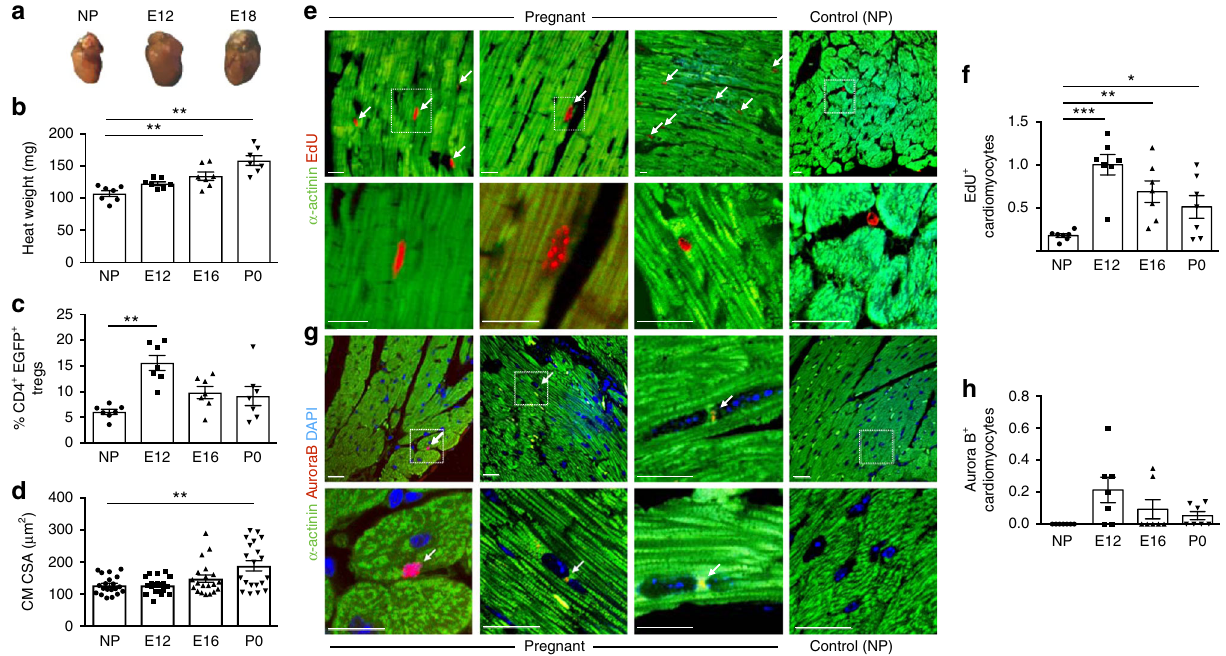
Fig. 3 Hyperplasia contributes to increased heart size in pregnancy. a Hearts harvested from not pregnant (NP) and pregnant female mice, at the indicated stages of embryonic development (E12 and E18). b Quanti fi cation of weight of the heart in not pregnant (NP, circles) and pregnant female mice, at the indicated stages of embryonic development (E12, squares and E18, tip up triangles) and at the day of the delivery (P0, tip down triangles). c Quanti fi cation of circulating Tregs in the peripheral blood of DEREG mice, expressed as the percentage of EGFP + cells over the total number of CD4 + cells at the same time points as in ( b ). d Quanti fi cation of the CM cross-sectional area (CSA) in heart sections of mice at different stages of pregnancy, as in ( b , c ). e Sections of the heart of pregnant mice at E12, showing a relatively high level of EdU incorporation (stained red) in the nuclei of CMs (stained green) compared to a control, not pregnant (NP) female heart. Scale bar, 100 μ m. f Quanti fi cation of EdU incorporation (% of total CM nuclei) in CMs of not pregnant (NP) and pregnant female mice, at the indicated stages of embryonic development (E12 and E18) and at the day of the delivery (P0). g Sections of the heart of pregnant mice at E12 showing Aurora B localization in midbodies (stained red) of CMs (stained green by anti- α -actinin antibodies). Nuclei are stained blue with DAPI. No Aurora-B signal is present in control, not pregnant (NP) female heart. Scale bar, 100 μ m. h Quanti fi cation of the AuroraB + (% of total CM nuclei) in CMs of not pregnant (NP) and pregnant female mice, at the indicated stages of embryonic development (E12 and E18) and at the day of the delivery (P0). All values are mean ± s.e.m., each dot indicates a biological replicate. One-way analysis of variance and Bonferroni/Dunn ’ s post hoc tests were used to compare multiple groups. * P < 0.05, ** P < 0.01, *** P < 0.001 relative to